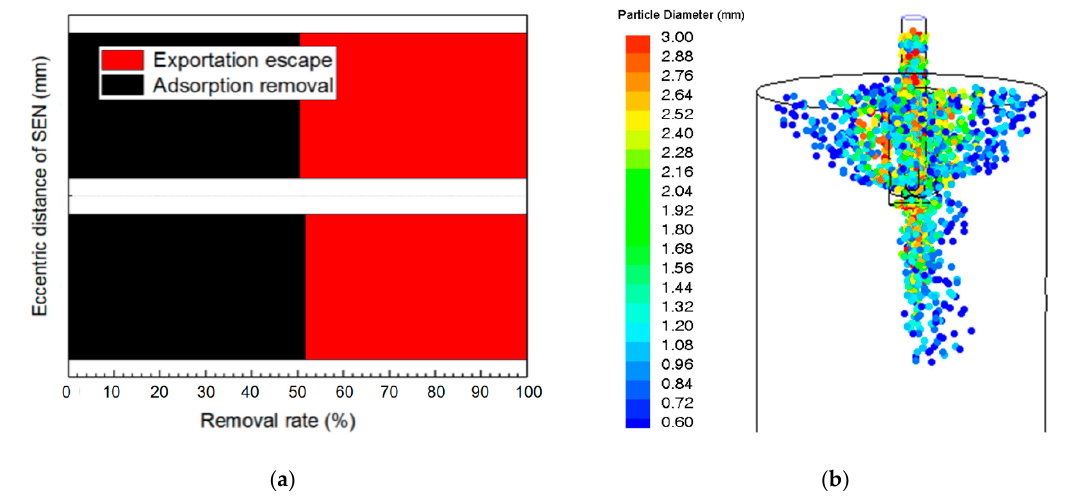
Figure 18. Inclusion removal rates and distribution of bubbles for the optimized swirling SEN. ( a ) Inclusion removal rates; ( b ) Distribution of argon bubbles.